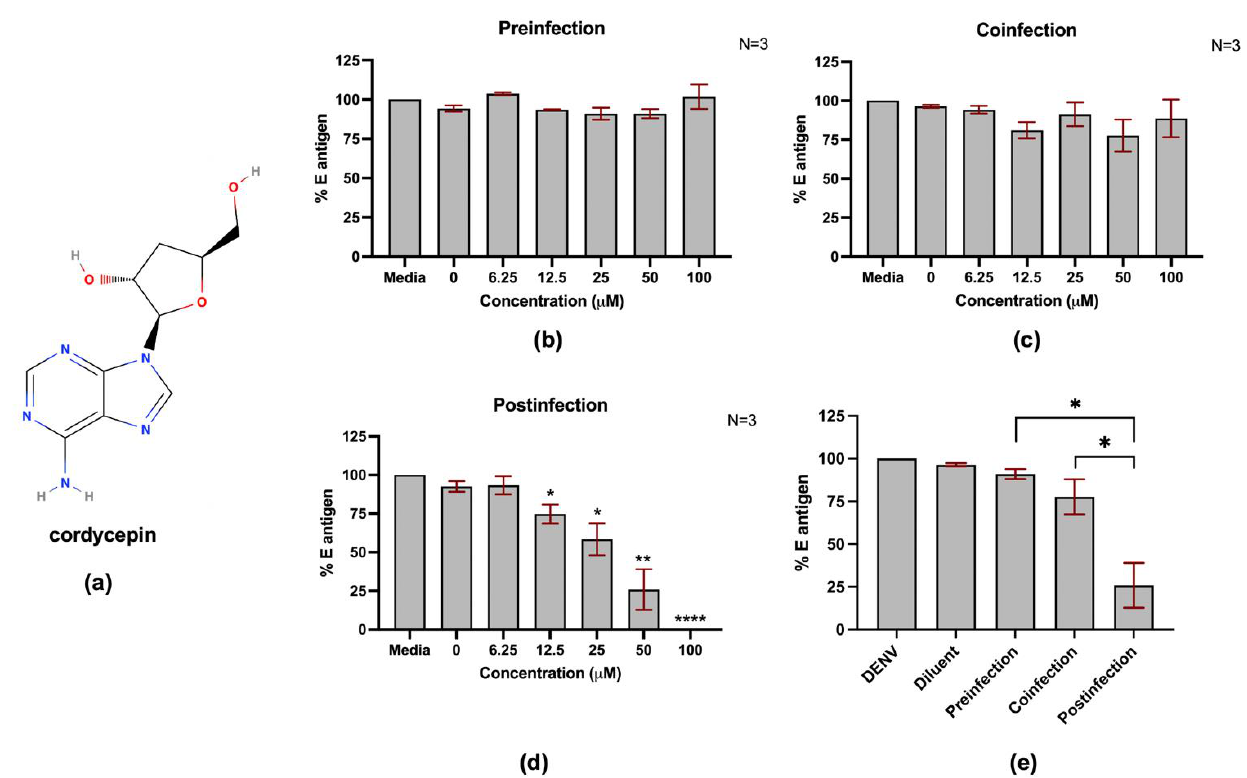
Figure 1. Anti-DENV activity of cordycepin in DENV2-infected Vero cells. Chemical structure of cordycepin ( a ). The inhibitory effect of cordycepin and its modes of action were determined by time-of-addition assay. ( b – d ) Vero cells were treated with cordycepin before (preinfection), during (coinfection), and after (postinfection) DENV2 infection. DENV2 envelope (E) protein levels were examined 48 h postinfection, and the percentages of DENV2 E protein levels relative to that of non-treatment control (set as 100%) were calculated. ( e ) The inhibitory effects of cordycepin at 50 µ M were compared for different addition steps. (* indicates p < 0.05; ** indicates p < 0.01; and, **** indicates p < 0.0001.)